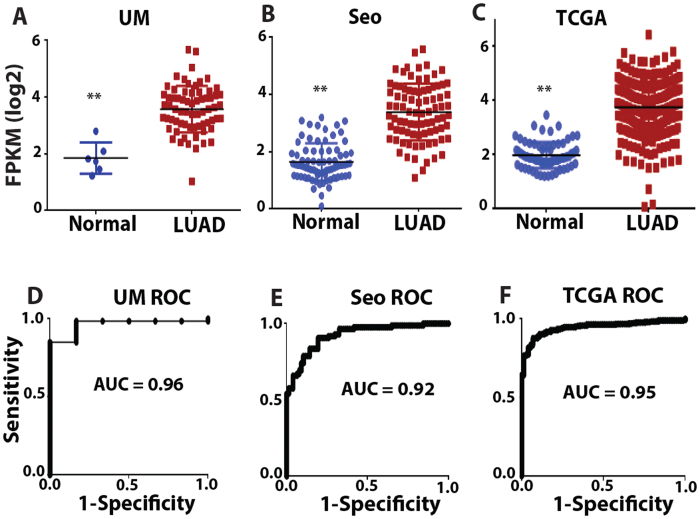
Increased FAM83H-AS1 expression in lung ADs.(A–C) scatterplots of FAM83H-AS1 expression levels in LUAD and normal lung tissue samples in UM (67 LUAD vs. 6 Normal), Seo (85 LUAD vs. 77 Normal) and TCGA (309 LUAD vs. 73 Normal) RNA-Seq datasets (LUAD vs. Normal, p < 0.001 in all 3 data sets). (D–F) Receiver Operating Characteristic (ROC) curves of FAM83H-AS1 in UM, Seo and TCGA RNA-Seq data sets (LUAD vs. Normal). The area under the curve (AUC) >0.9 in all 3 data sets.